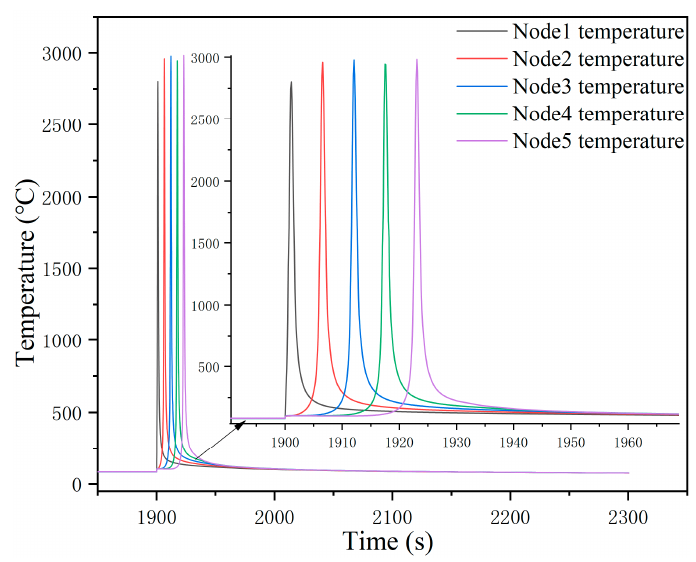
Figure 16. HESD repair welding temperature history.